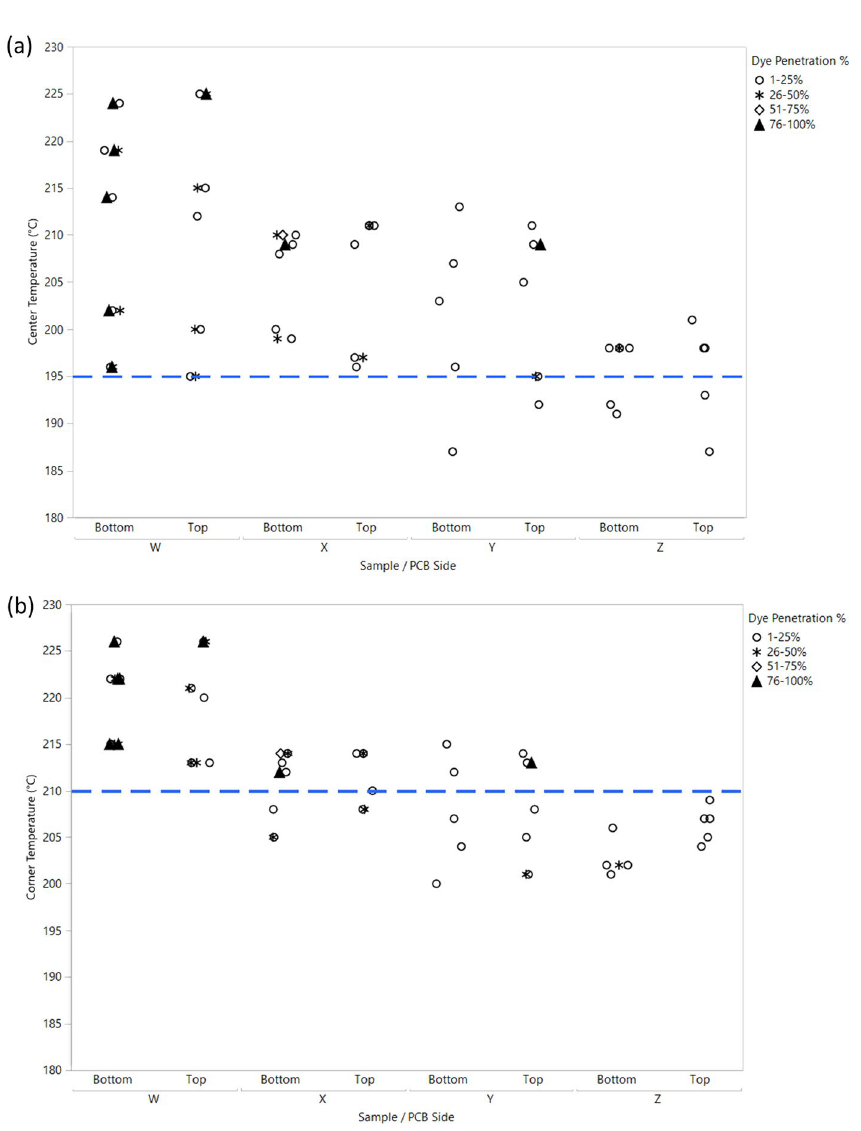
Figure 6. Dye penetration% with the impact of temperature differences at the BGA component area: ( a )— centre of the BGA components; ( b )—corner of the BGA